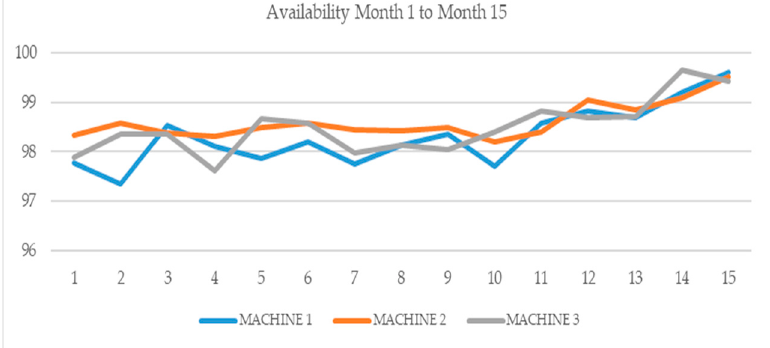
Figure 11. Machine availability evolution. The three machines analyzed were in the same production line and each of them had different architectures and tasks. Table 1 represents the data used for training the anomaly